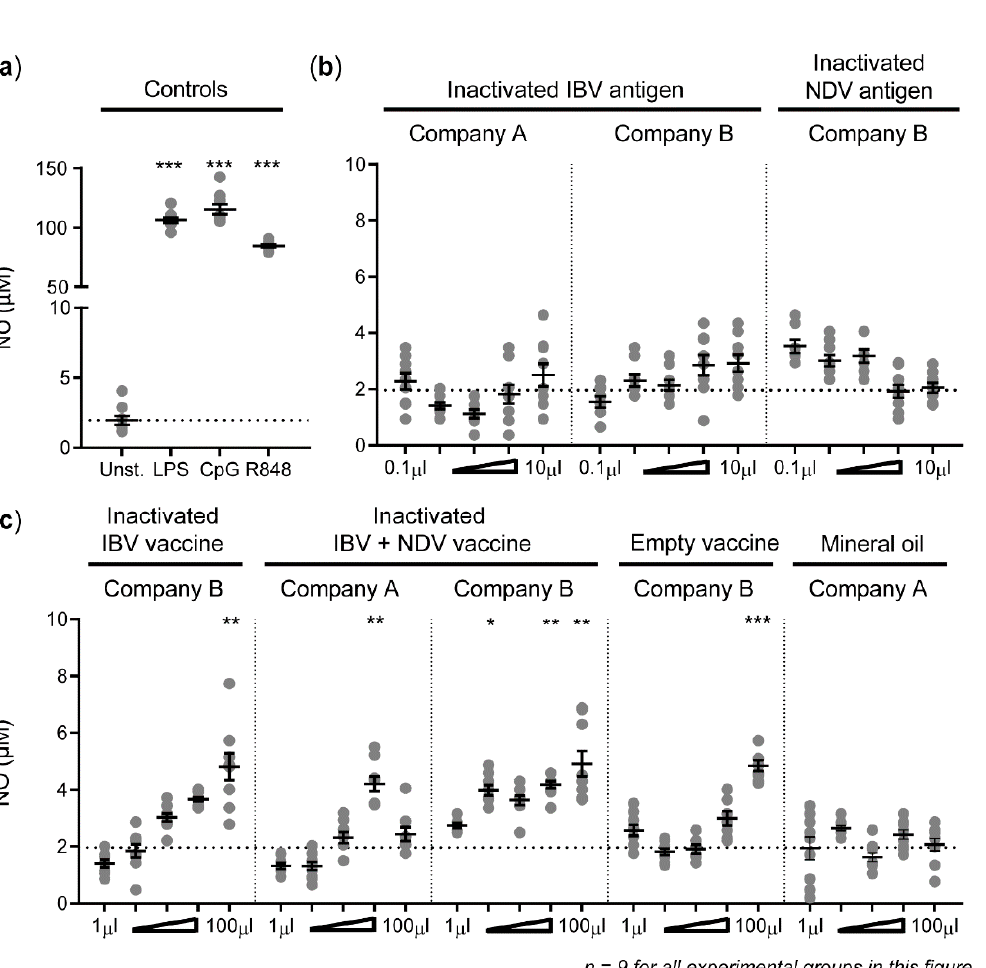
Figure 1. Inactivated poultry vaccines induced nitric oxide production by HD11 cells, whereas inactivated IBV and NDV antigens did not. ( a ) Nitric oxide production by HD11 cells was assessed upon stimulation with TLR agonists, i.e., 100 ng / mL LPS, 100 ng / mL CpG, and 10 µ g / mL R848. ( b ) In addition, HD11 cells were exposed to inactivated IBV and NDV antigens (companies A and B) in doses ranging from 0.1–10 µ L / mL. ( c ) Finally, HD11 cells were exposed to vaccines, an “empty vaccine” containing allantoic fluid without inactivated viruses, and mineral oil in doses ranging from 1–100 µ L / mL. Three independent experiments were performed, and the experimental conditions of each independent experiment were tested in triplicate. Error bars represent the standard error of the mean (SEM). The experimental groups were tested for statistically significant increases in nitric oxide production as compared to unstimulated HD11 cells using a Kruskal–Wallis test and Dunn’s multiple comparisons test. Statistical significance is indicated by * p < 0.05, ** p < 0.01, and *** p <